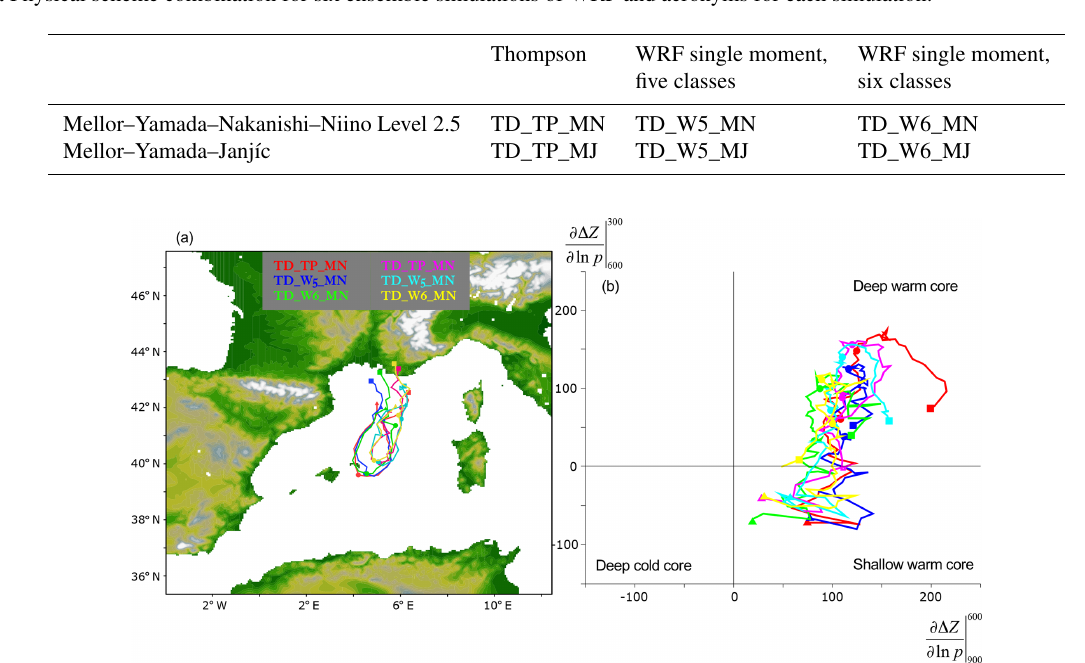
Table 2. Physical scheme combination for six ensemble simulations of WRF and acronyms for each simulation.